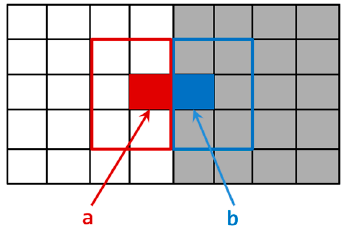
Figure 6. Step edge grayscale distribution map; pixel “a” and “b” are on the